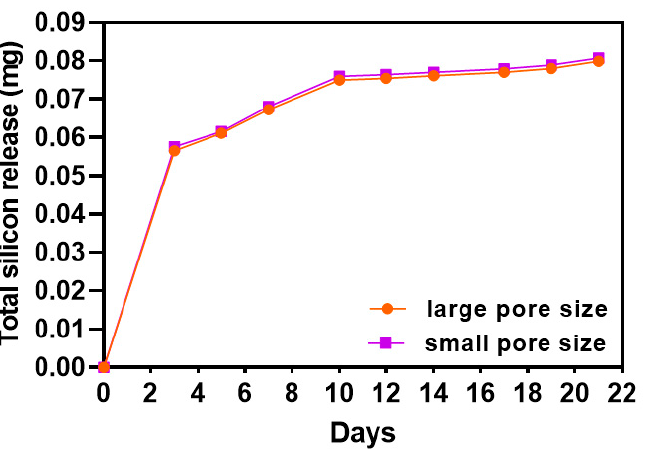
Figure 3. Silicon ion release curve. n =